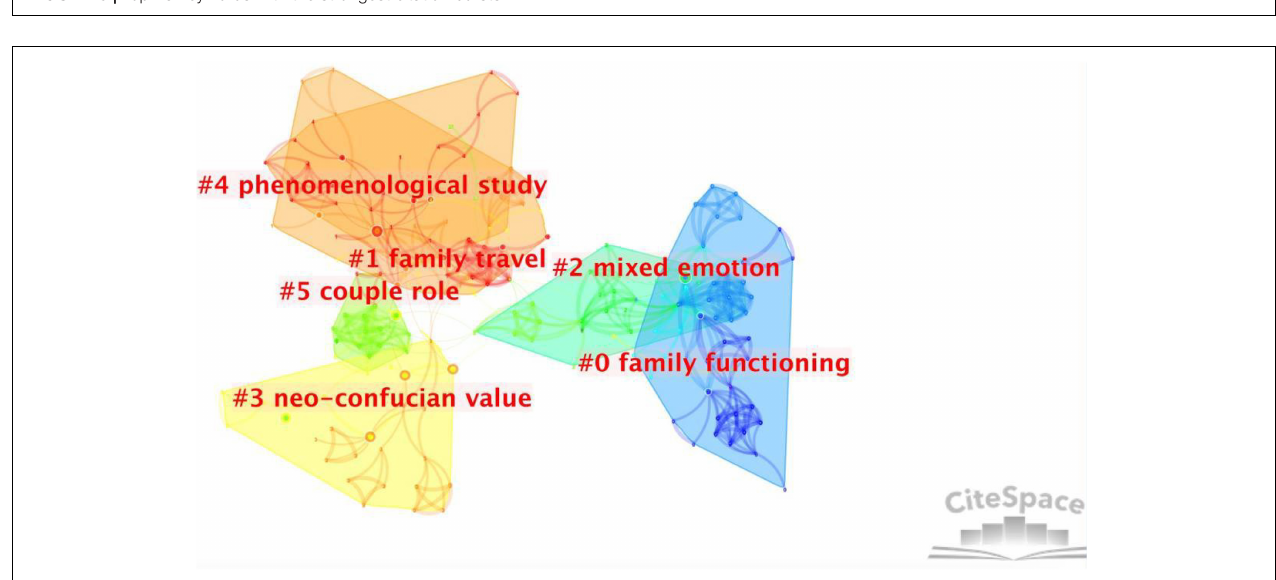
FIGURE 6 | Cluster analysis of the reference co-citation